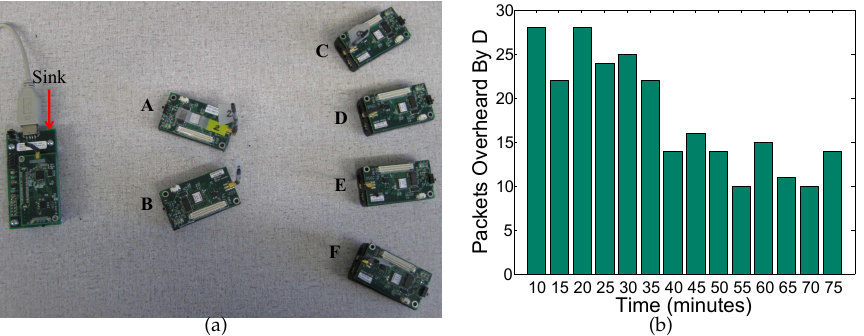
Figure 10. Illustration of experimental tests used to evaluate the effectiveness of dynamic transmit channel selection. ( a ) Network layout; ( b ) variations of packets overheard by node D over